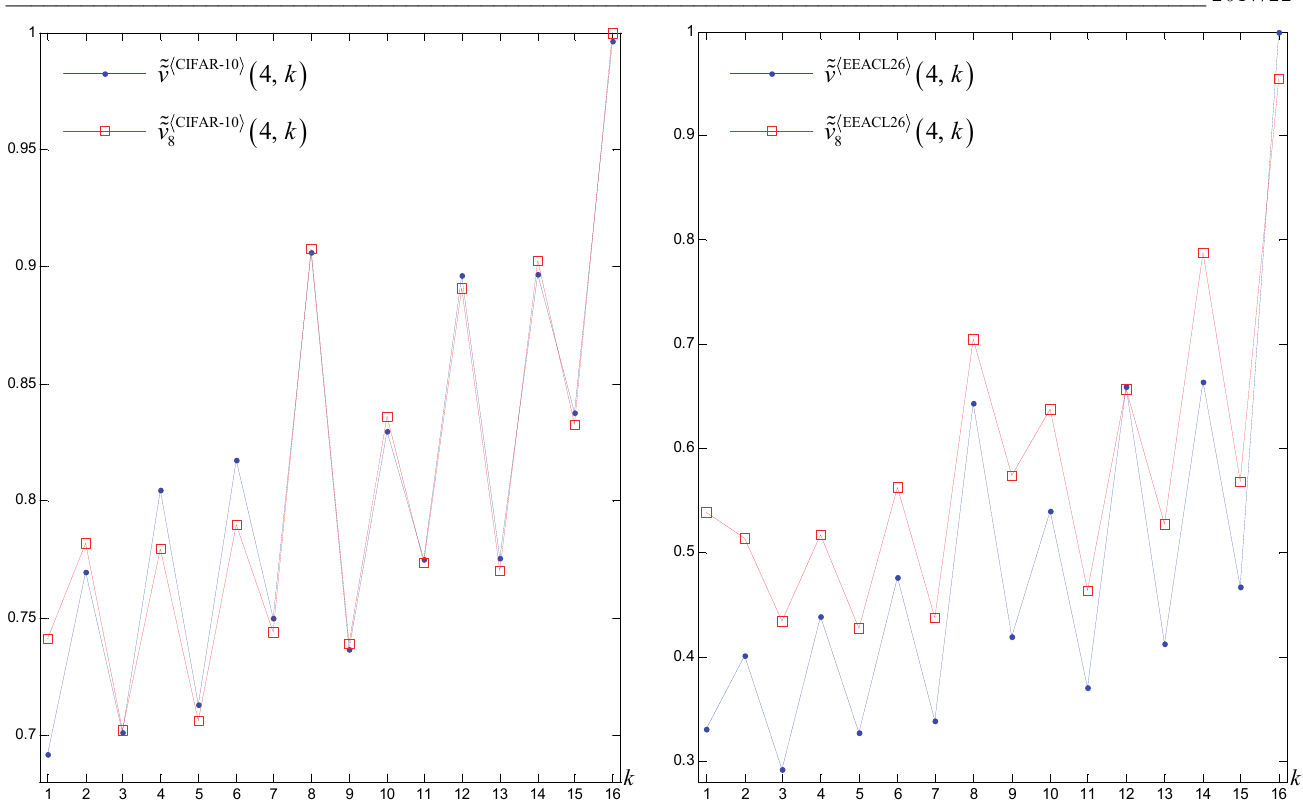
Fig. 4. Performance of CNNs with 4 ConvLs on CIFAR-10. Minimum points of these polylines are different ( k = 1 and k = 3), but close to each other.